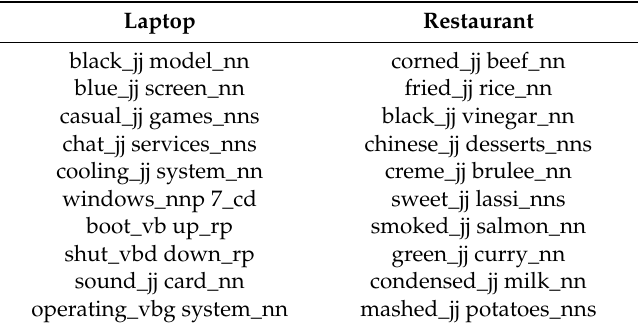
Table 4. Compound noun lexicon (only displaying 10 examples